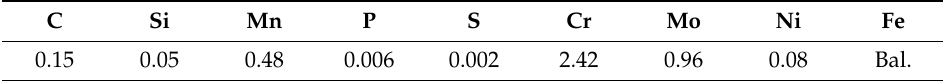
Table 1. The nominal chemical composition of 2.25Cr-1Mo steel (in wt %).